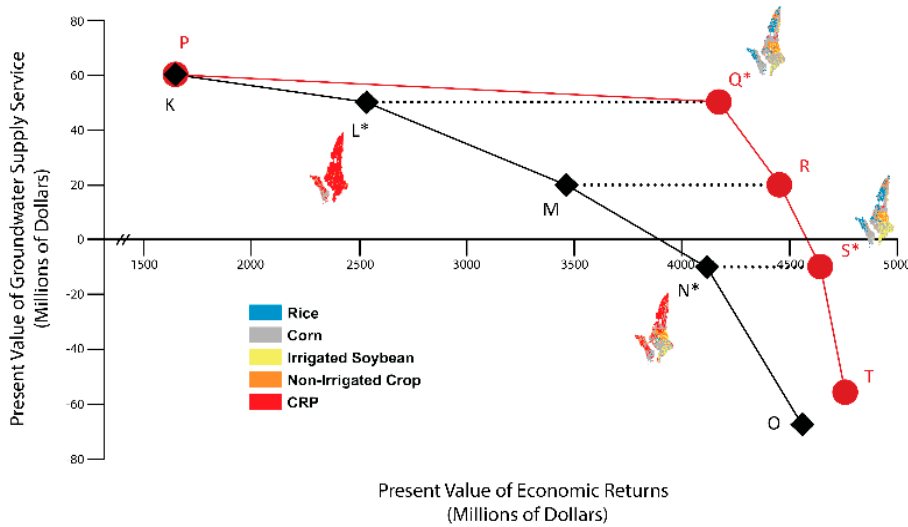
Figure 3. Crop mix patterns associated with specific points along the efficiency frontiers without reservoirs and with reservoirs that show the tradeoff of economic returns and groundwater supply. Each crop mix pattern shown beside the efficiency frontiers correspond to a lettered point with an asterisk on the frontiers. Efficiency frontiers are farther apart than in Figure 2 suggesting reservoirs substantially increase economic efficiency when only groundwater supply matters.